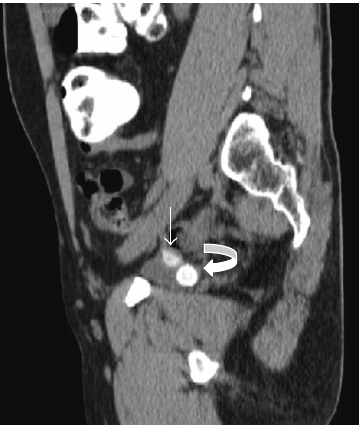
Figure 1: In CT images of the patient, bladder is not full enough but 2cm hyperdense calculi are seen in posterior inferior part of bladder (curved arrow) and hyperdense fecalith image is seen in right superior posterolateral part of bladder (arrow).